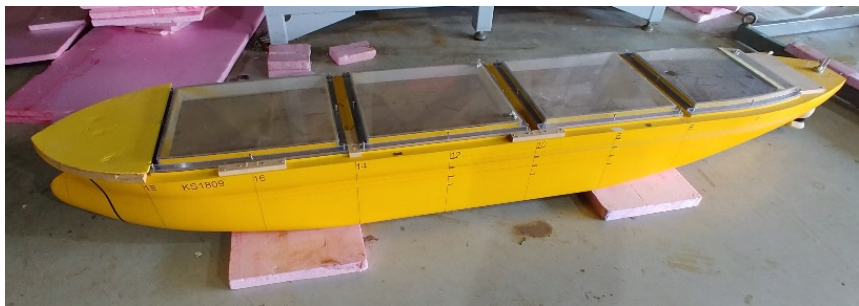
Figure 1. Experimental model of KVLCC2. Table 1. Main dimensions of KVLCC2.